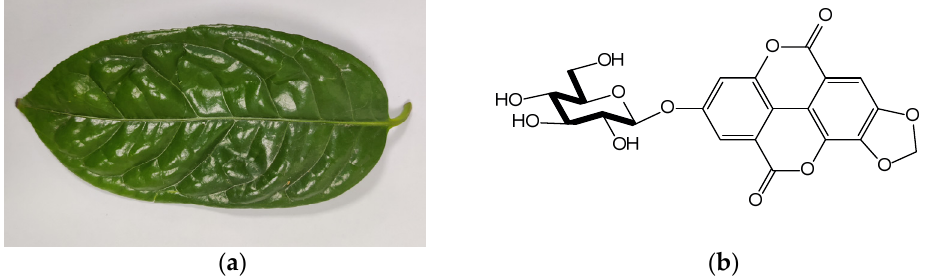
Figure 1. ( a ) Camellia nitidissima Chi leaf; ( b ) Okicamelliaside structure diagram. OCS (Figure 1b) is present in C. nitidissima leaves and its structure was elucidated as